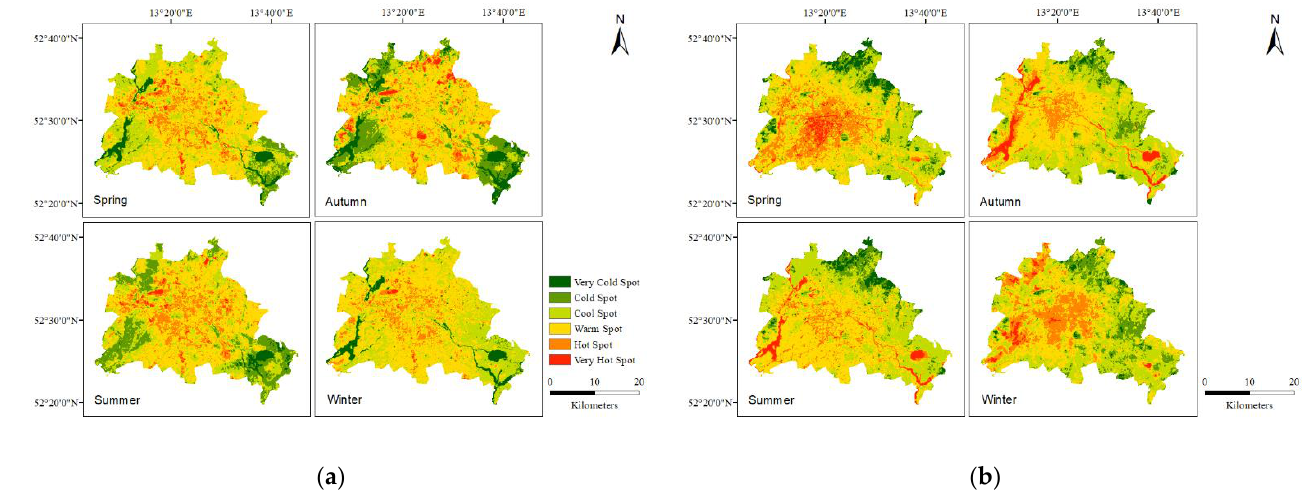
Figure 4. The spatial distribution of LST in ( a ) daytime and ( b ) nighttime.